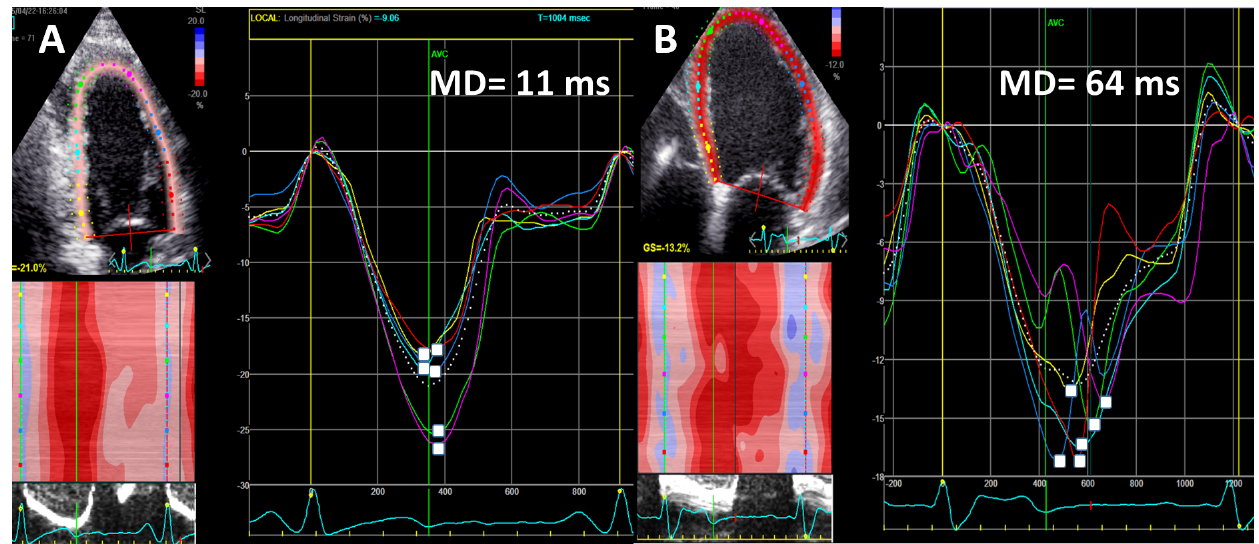
Figure 4. Mechanical dispersion (MD) of the segmental peak longitudinal strain. ( A ) Normal heart. All strain curves peak around aortic valve closure (AVC). ( B ) Infarct patient with inducible arrhythmias in the electrophysiology lab. Note the wide dispersion of the segmental peak strains. Abbreviations: GS, global